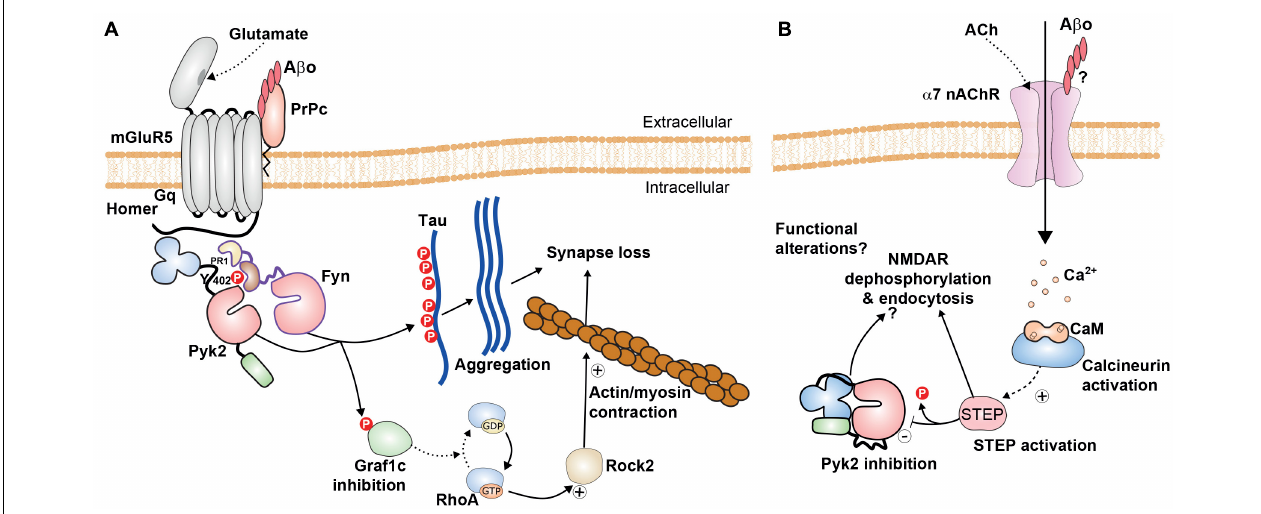
FIGURE 5 | Possible roles of Pyk2 in Alzheimer’s disease. (A) Pyk2 is likely to be a component of the amyloid cascade mechanisms. Pyk2 can be associated with the complex between mGluR5 and Prp c , associated with homer. The binding of A β oligomers (A β o) to Prp c , a glycosylphosphatidylinositol-anchored extracellular protein, impairs normal signaling of mGluR5 but triggers the activation of Fyn and Pyk2. These kinases phosphorylate Tau and may thus facilitate its aggregation and the formation of neurofibrillary tangles. Pyk2 also phosphorylates the RhoA GTPase Graf1c, inhibiting its activity, increasing active RhoA/GTP, resulting in activation of Rock2 and actin/myosin contraction that can contribute to synaptic alterations [see references in the text and (Brody and Strittmatter, 2018)]. (B) These pathways can potentially play a different role, possibly in different neurons or at different localizations or different times in the same neurons, with activation of STEP, for example following Ca 2 + entry through α 7 nicotinic acetylcholine receptor ( α 7nAChR) and activation of calcineurin. This could result in tyrosine dephosphorylation of Pyk2 and NMDAR, decreased NMDAR surface expression, and functional synaptic alterations. The balance between the mechanisms depicted in (A,B) is not known and may depend on experimental models and conditions. Additional roles of Pyk2 are possible but not explored, including in microglial cells (not